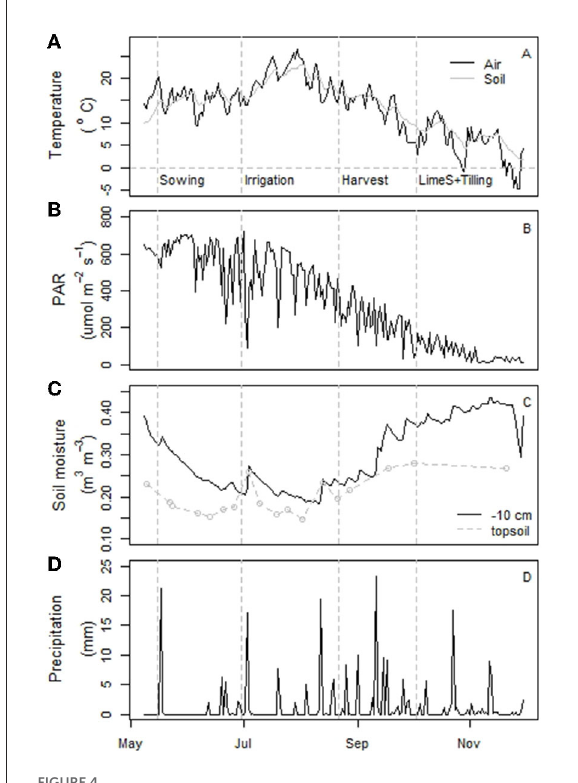
FIGURE4 Daily mean air and soil temperature at a depth of 100mm (A) , photosynthetically active radiation (PAR) intensity (B) , soil moisture at 0.10m depth (C) , and precipitation (D) measured throughout the campaign year, 2018. The station did not record the irrigation on 30 June, which was ∼ 40–50mm and which temporarily increased the soil moisture in the experimental plots. Panel (C) also includes the mean manual topsoil moisture (0–0.05m)